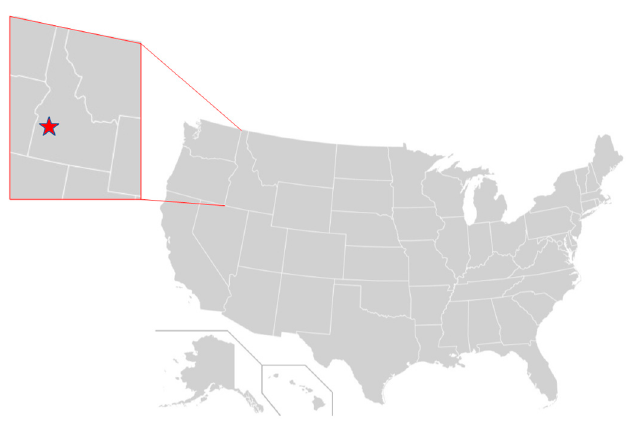
Figure 1. Location of Idaho within the United States and the city of Boise (red star) within the state of Idaho.